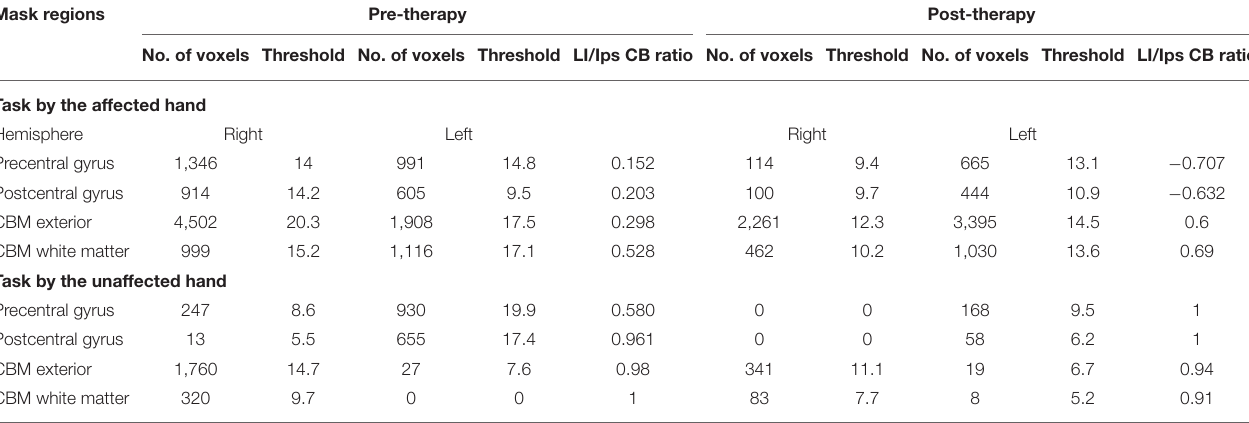
TABLE 2 | Pre and post-robotic sessions Blood Oxygen Level Dependent (BOLD) activation pattern in affected and unaffected hand trials in mask regions. Mask regions Pre-therapy